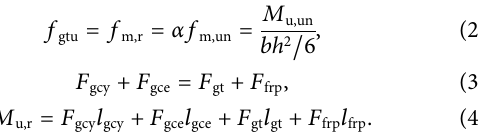
Frontiers in Materials |